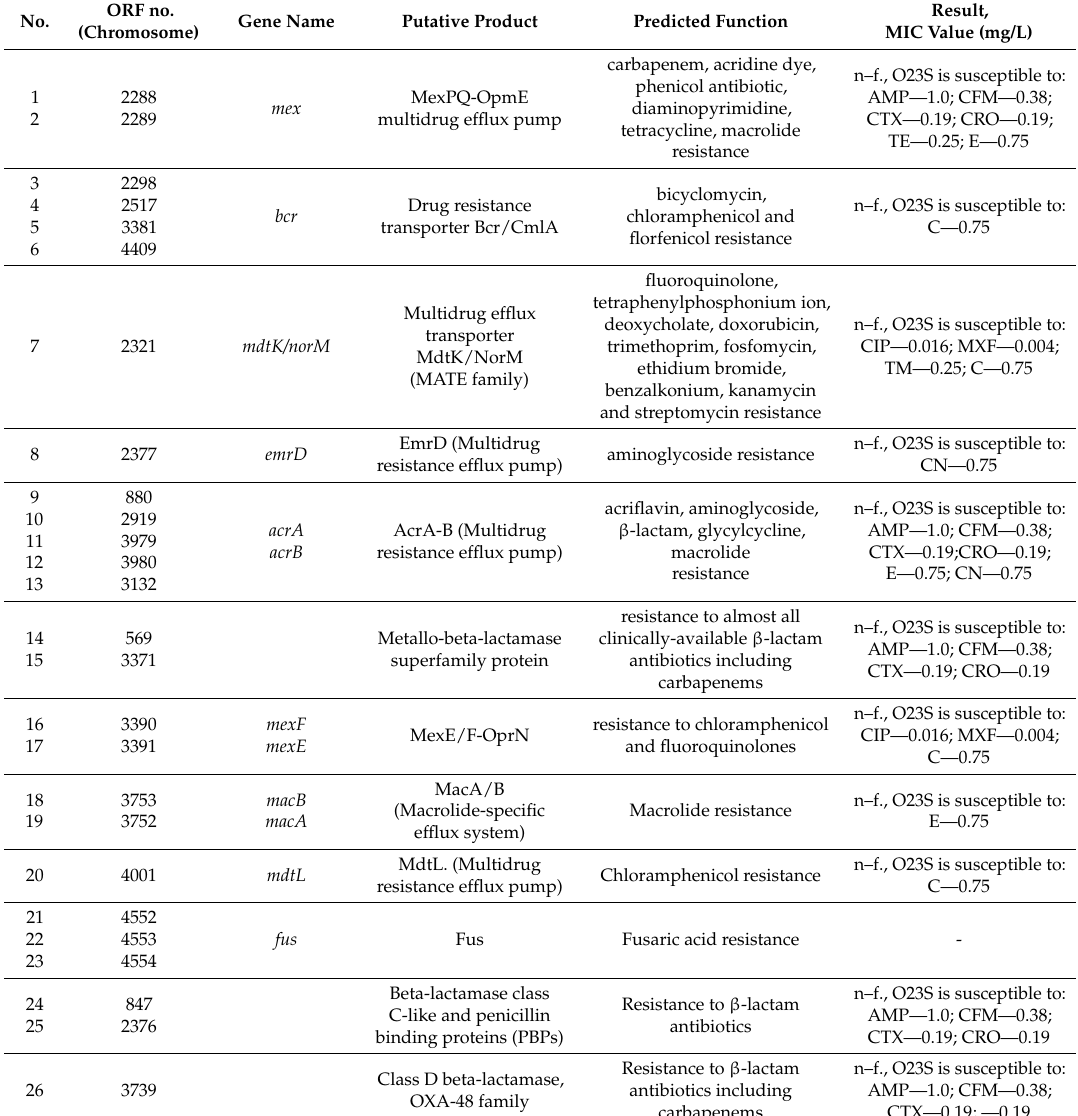
Table 5. Putative antibiotic resistance genes of the O23S strain and MIC